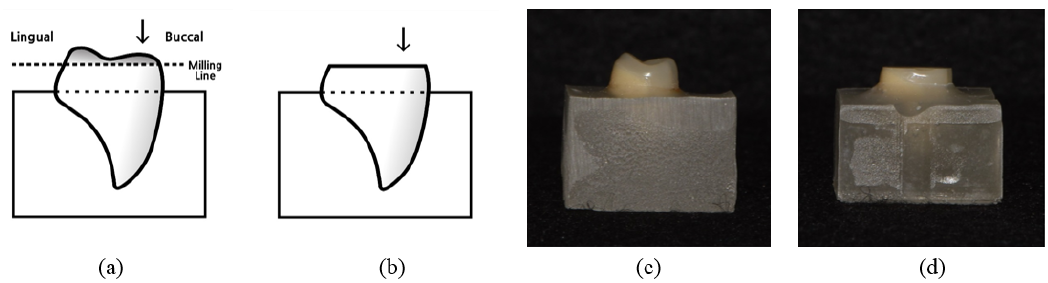
Figure 1. Schematic drawing of a resin tooth specimen. ( a ) The resin tooth was embedded in an orientation such that the occlusal surfaces of the mesiobuccal and distobuccal cusps were parallel to the horizontal (floor). ( b ) The embedded resin tooth was ground down evenly in height by 0.5 mm using a surveyor milling machine. Arrow indicates the direction of vertical load. ( c ) Embedded resin tooth with acrylic resin. ( d ) Prepared resin tooth specimen.